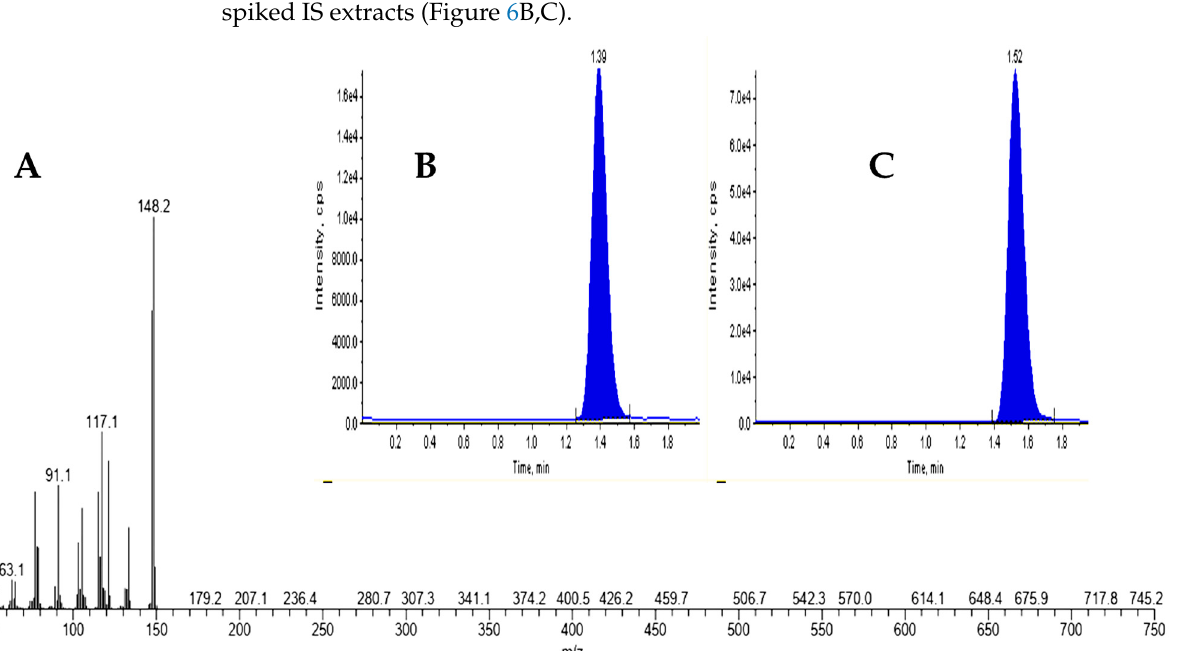
Table 12. Fragmentation ion and the retention time for estragole standard as well as the quantitative assessment of estragole in aniseed.